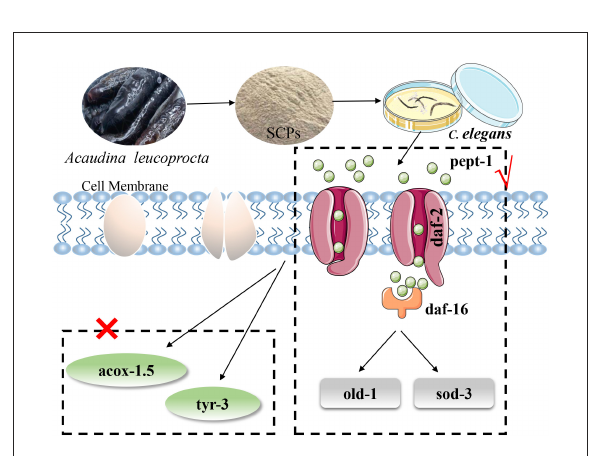
FIGURE7 SCPs extended the lifespan of C. elegans could through the IIS pathway ( pept-1 , daf-2 , daf-16 , old-1 , sod-3 ) but not apoptosis and Dauer